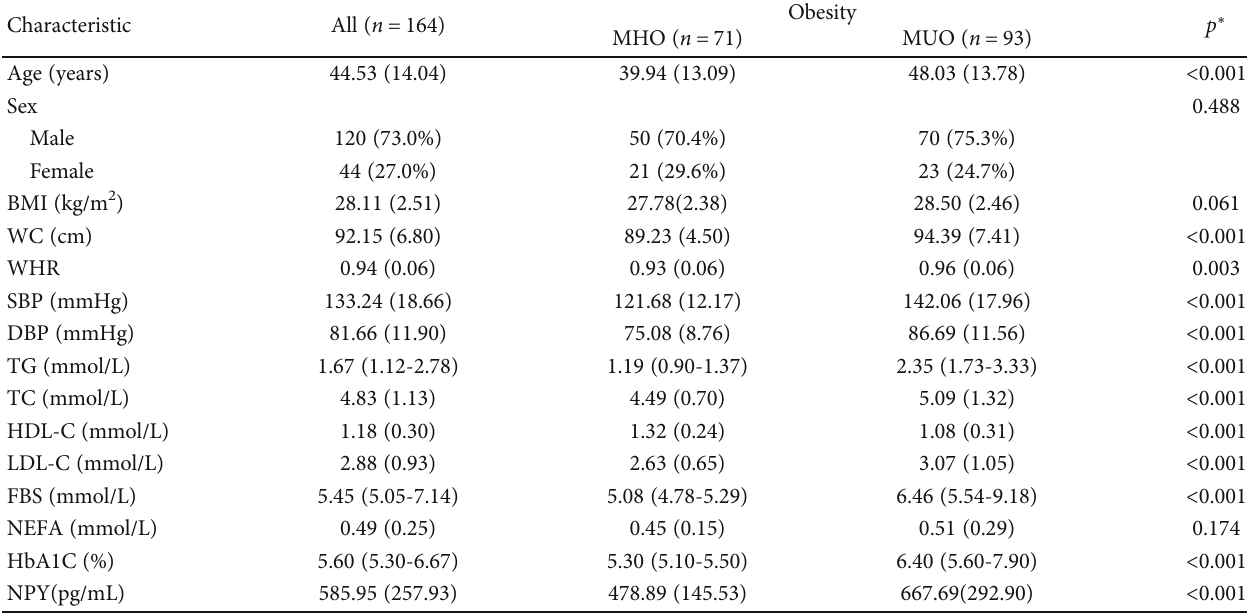
Table 1: Baseline characteristics of the study participants ( N = 164